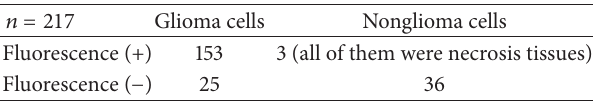
Table 1: The relationship between the fluorescence and the patho- logical examination. 𝑛 = 217 Glioma cells Nonglioma cells Fluorescence (+) 153